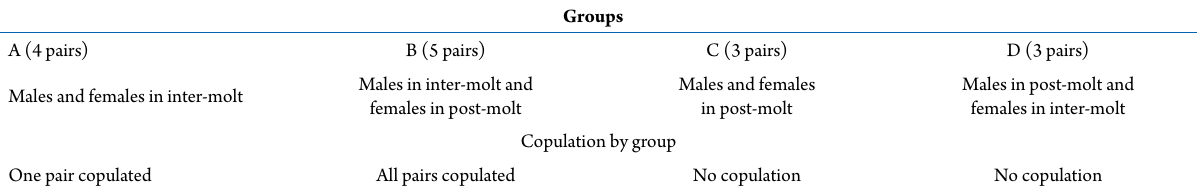
Table 1. Kingsleya attenboroughi Pinheiro and Santana, 2016, pair arrangements in the four groups (A–D).